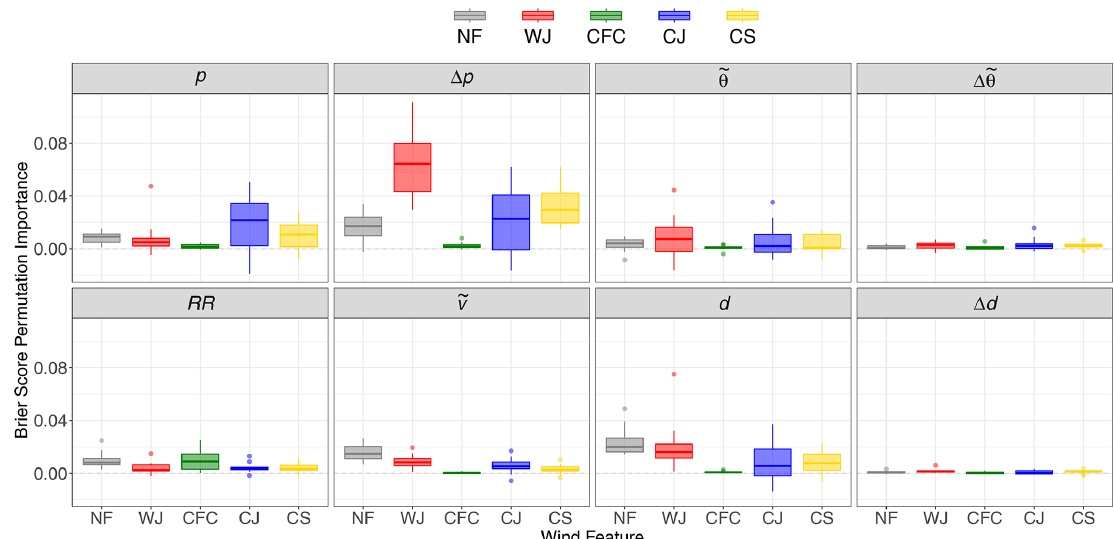
Figure 8. Boxplots of the BS permutation importance of the RF probabilities for the individual wind features and predictor variables in the one-against-all approach. The boxplots are calculated over the individual winter storms.